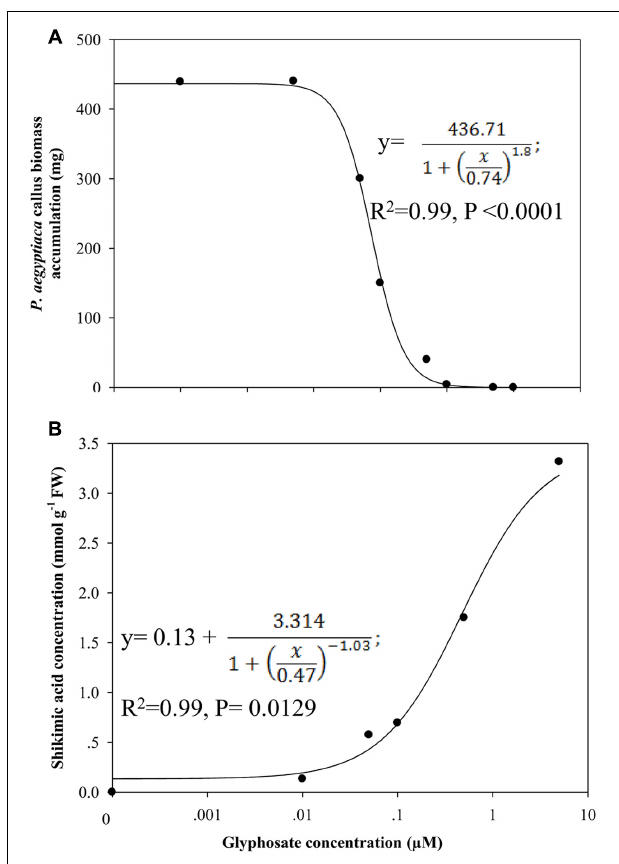
FIGURE 6 | Biomass accumulation of P. aegyptiaca callus (A) and shikimic acid accumulation in the callus (B) cultured on BCGM containing glyphosate. The experiment was conducted with eight replicates. Data were computed by non-linear regressions using Sigma-Plot version 11.01. (A) For biomass: y